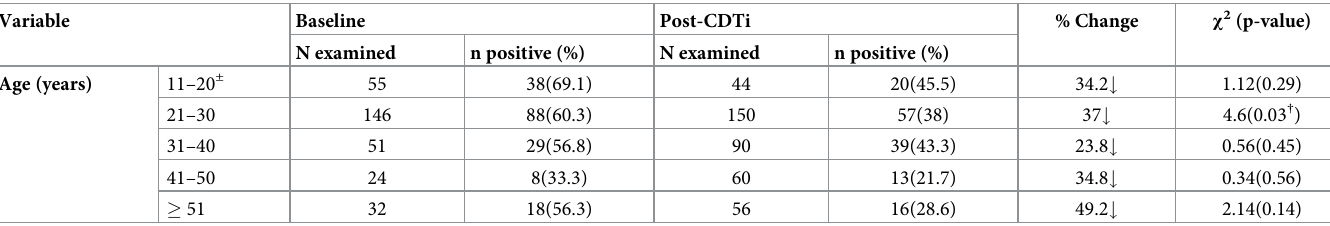
Table 4 compares the baseline and post-CDTi STH prevalence data based on the age of the study participants. SAC are involved in the recently launched MDA program against STH in Yeki. For comparison of the current prevalence rates of any helminth infection with the base- line prevalence, study participants younger than 15 years were excluded and only data from 400 individuals were considered for analysis. Before the launch of CDTi, the overall prevalence of any STHs was 58.8% (95% CI 53.2–64.1%) (181/308) [35]. Overall, a decline in the preva- lence of any STH infection was observed in the current study compared to the baseline within all age groups, however, the decline in the prevalence of any STH infection was significant only in the age group of 21–30 years (p = 0.03). Table 4. Baseline and post-CDTi prevalence of any STH infection disaggregated by age in Yeki district of southwest Ethiopia. Variable Baseline Post-CDTi % Change χ 2